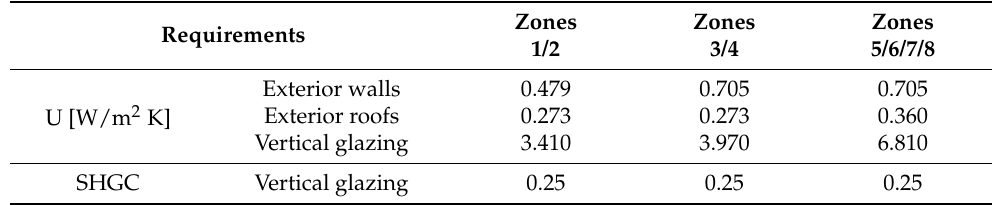
Table 2. Values of U and SHGC for representative cities